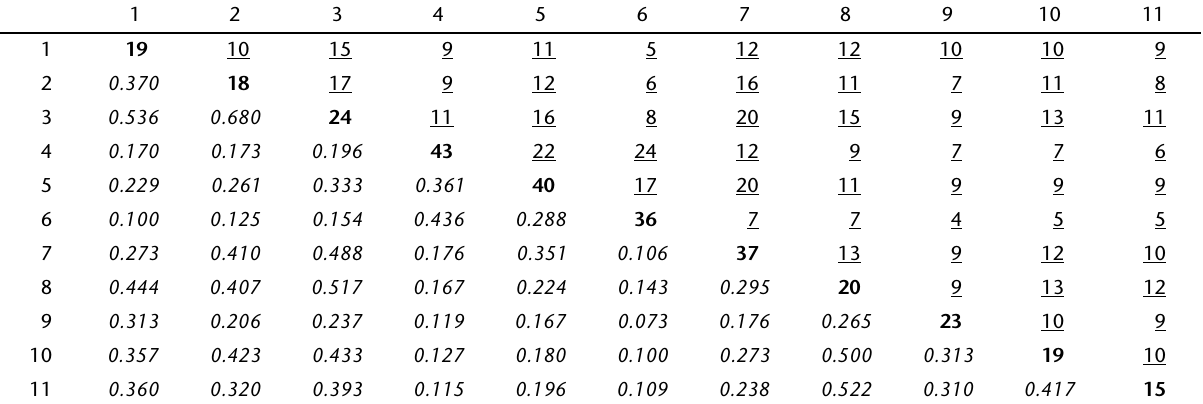
Table II. Similarity matrix with similarity indexes between pairs of assemblages (italics), number of shared species (underline), and species richness (bold) in each assemblage. Subtitles: Cerrado-Caatinga transition: (1) Castelo do Piauí, state of Piauí, (2) José de Freitas, state of Piauí, (3) Parque Nacional de Sete Cidades (PNSC), state of Piauí. Cerrado: (4) Parque Nacional das Emas, state of Goiás, (5) Manso hydroelectric powerplant, state of Mato Grosso, (6) Itirapina, state of São Paulo, (7) Urbano Santos, state of Maranhão. Caatinga,